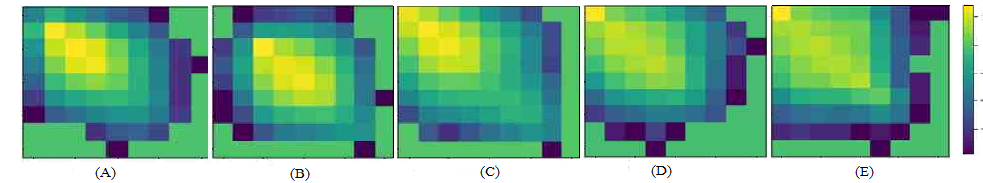
Figure 9. The Co-occurrence matrix DCGAN [35] ( A ), WGAN [25] ( B ), Pix2Pix GAN [17] ( C ), Proposed model ( D ) and the ground truth ( E ) in 3D. Table 4. Comparison of Haralick features for the generated images and the ground truth.